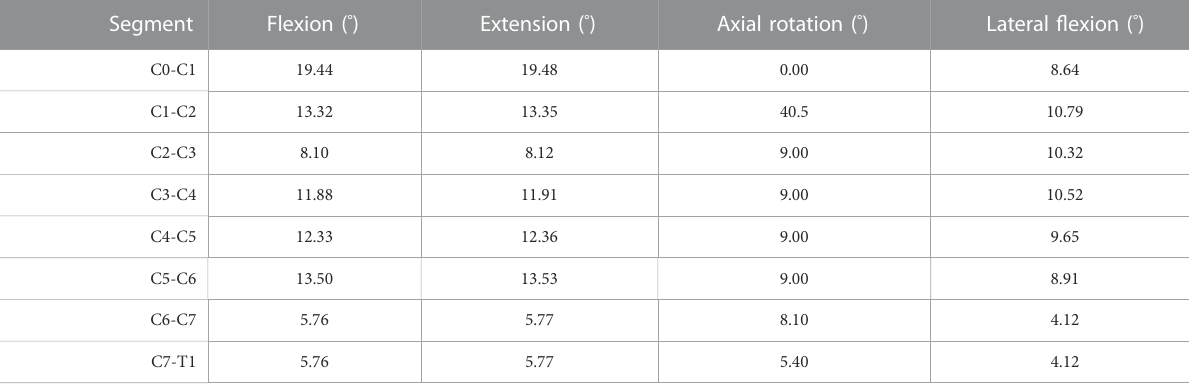
TABLE 1 The maximum intervertebral range of motion (degrees) for each bending mode of the cervical spine.